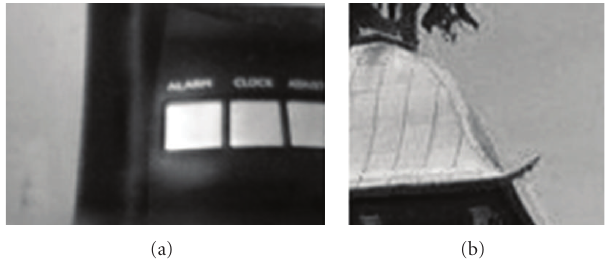
Figure 5: Table—the CA fusion of the image “Table,” 2 input images, approximate run time: 111 sec.